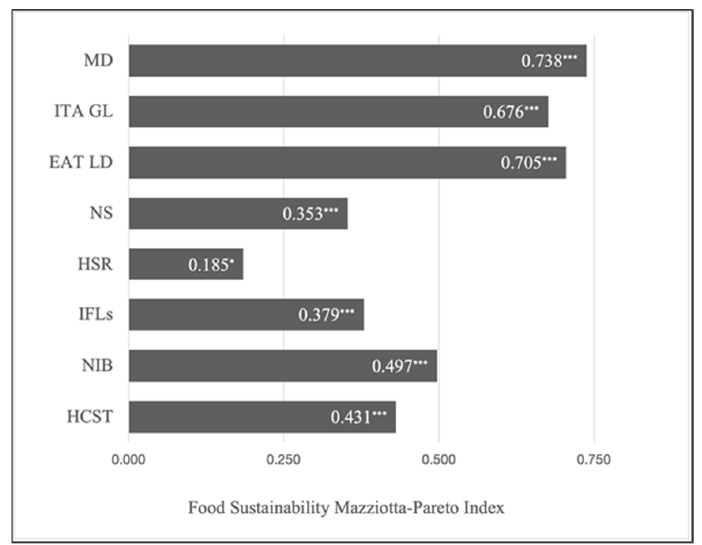
Figure 4. FOPLs and healthy and sustainable diets comparison using the Food Sustainability Mazziotta–Pareto Index as a composite index for the 8 sustainability indicators. Abbreviations: MD = Mediterranean Diet; ITA GL = Italian Dietary Guidelines; EAT LD = EAT Lancet Diet; NS = Nutriscore; HSR = Health Star Ratings; IFLs = Israeli Food labels; NIB = NutrInform Battery; HCST = Health Canada Surveillance Tool. ***: p < 0.001; *: p ≤